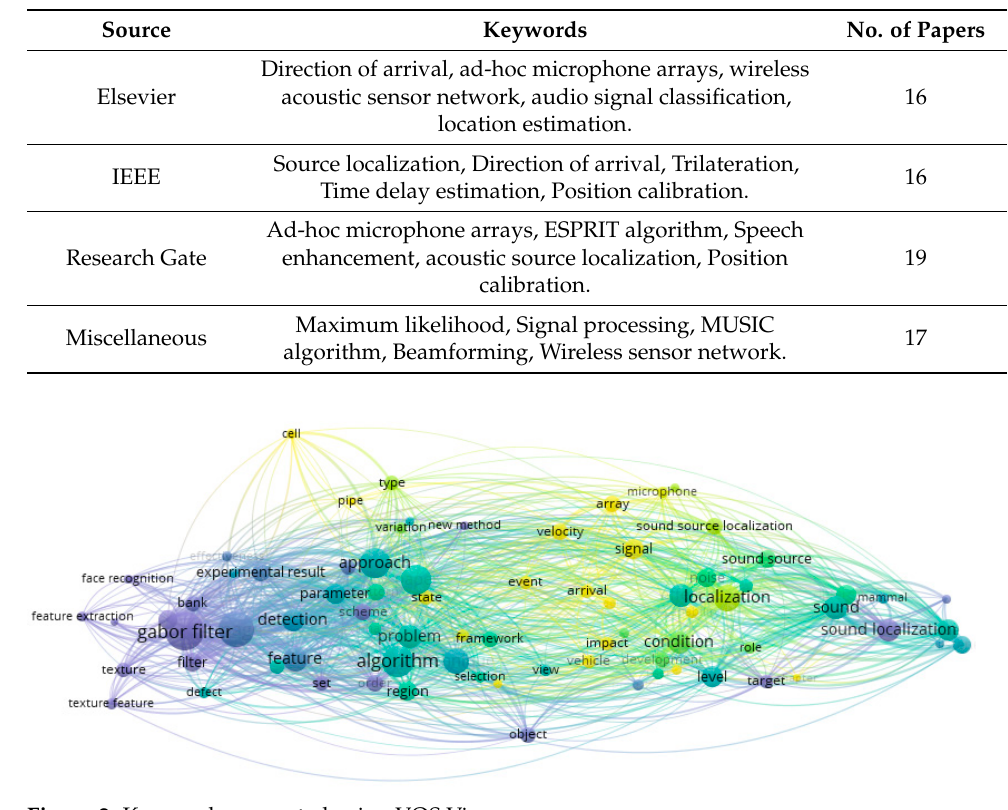
Figure 2. Keywords generated using VOS Viewer.